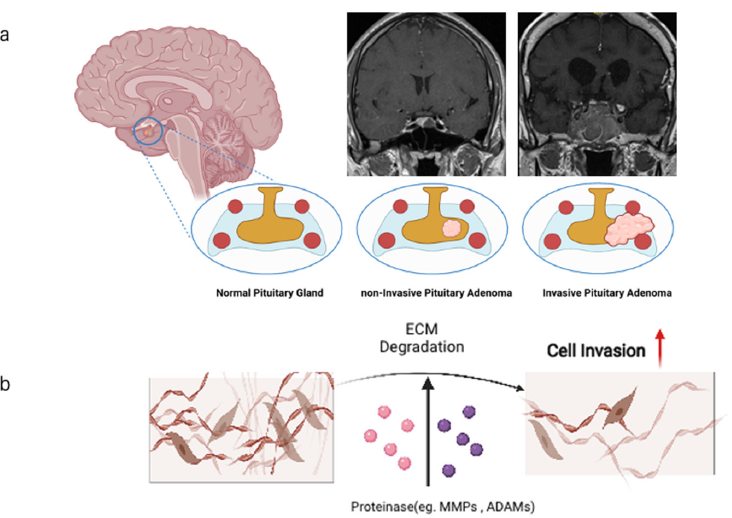
Figure 1. ( a ) Pituitary gland located in the sella turcica shown in coronal sections as normal pituitary gland, benign pituitary adenoma, and as invasive pituitary adenoma. Internal carotid arteries adjacent to the pituitary are depicted as red circles. Cavernous sinuses are depicted in light blue. Note that aggressive PAs tend to circumvent the arteries. ( b ) Cellular mode of invasion into the brain tissue depends on degradation of extracellular matrix (ECM) molecules by proteinases of the metzincin family, namely MMPs and ADAMs. All images produced with Biorender (https://biorender.com (accessed on 6 November